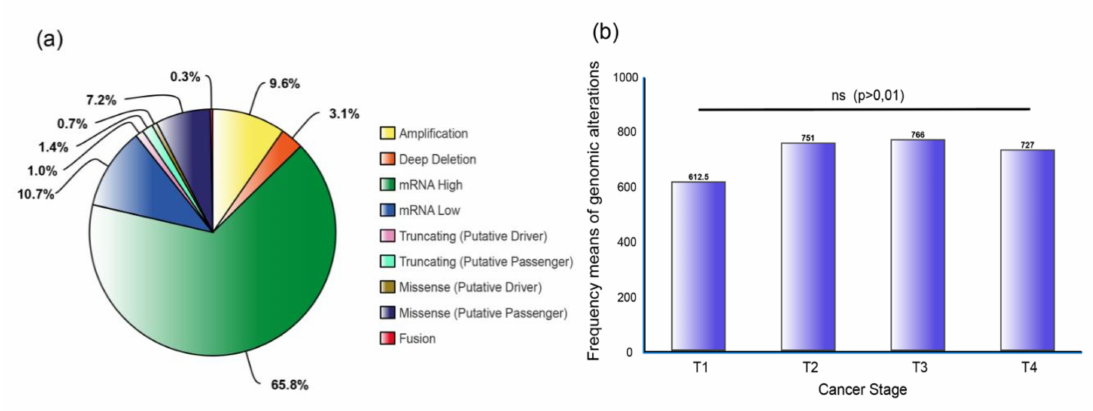
Figure 2. Genomic alterations. ( a ) Percentage of genomic alterations of 411 ALT-related genes distributed in the 31 PCA studies. ( b ) Frequency means of genomic alterations of the 411 genes in di ff erent cancer stages; no significant di ff erence was observed after Bonferroni correction test ( p > 0.01). All values were normalized by the number of samples in each